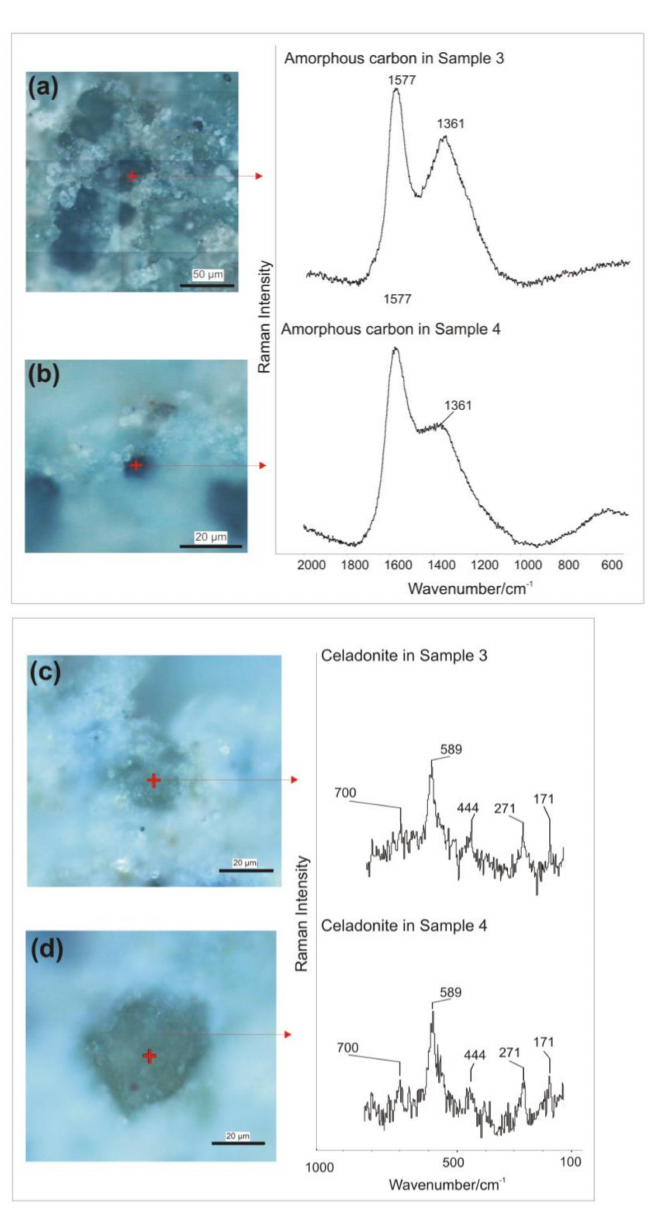
Figure 9. OM images of amorphous carbon under reflected light on the painted surfaces of Samples 3 ( a ) and 4 ( b ) with relative Raman spectra. OM images of celadonite under reflected light on the painted surfaces of Samples 3 ( c ) and 4 ( d ) with relative Raman